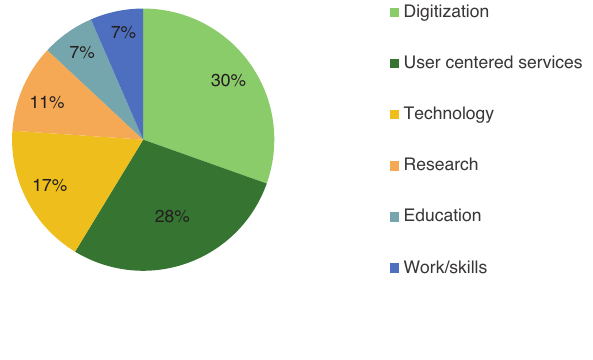
Fig. 3: How did existing figures influence your research library’s responses to the coronavirus